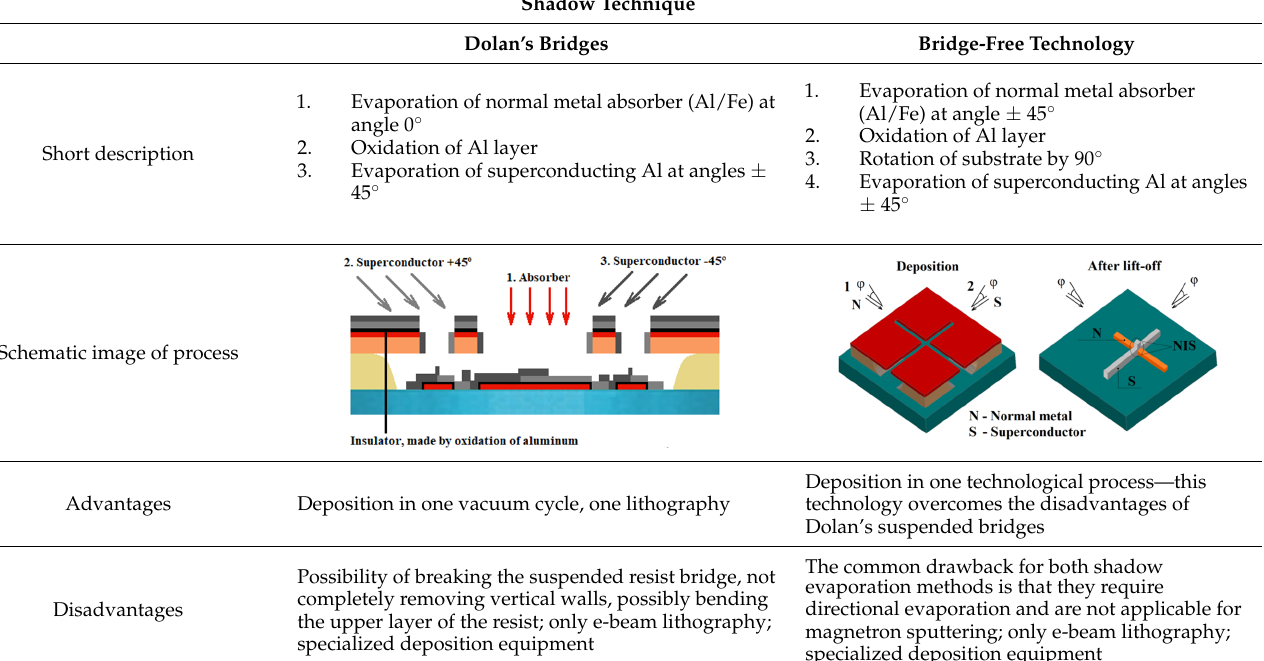
Table 2. Comparison of two main shadow technologies for the fabrication of Al tunnel junctions.